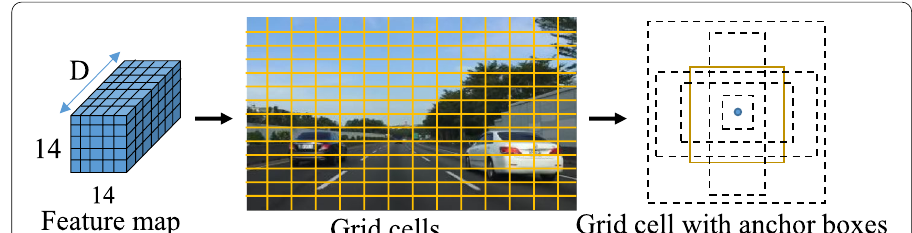
Fig. 3 Anchor boxes of iYOLO object detector